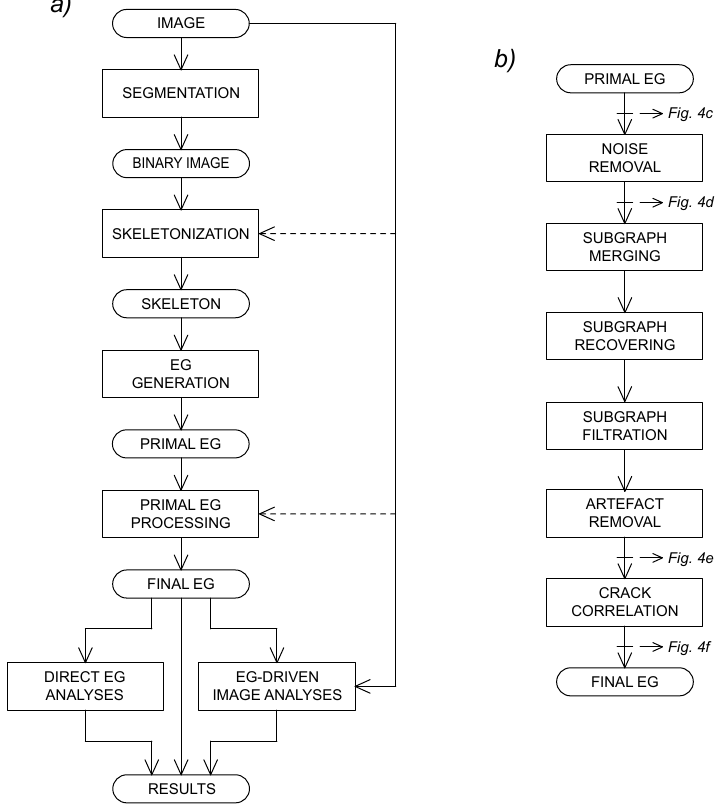
Figure 3. EG-mediated image processing flowchart. Complete image processing with primal EG generation and finishing to obtain the refined final EG suitable for downstream analyses. Advanced algorithms for skeletonization and processing of primal EG can also take advantage of the direct access to original image data ( a ). Detailed finishing process of primal EG ( b ). The outcome of selected processing steps is shown in Figure